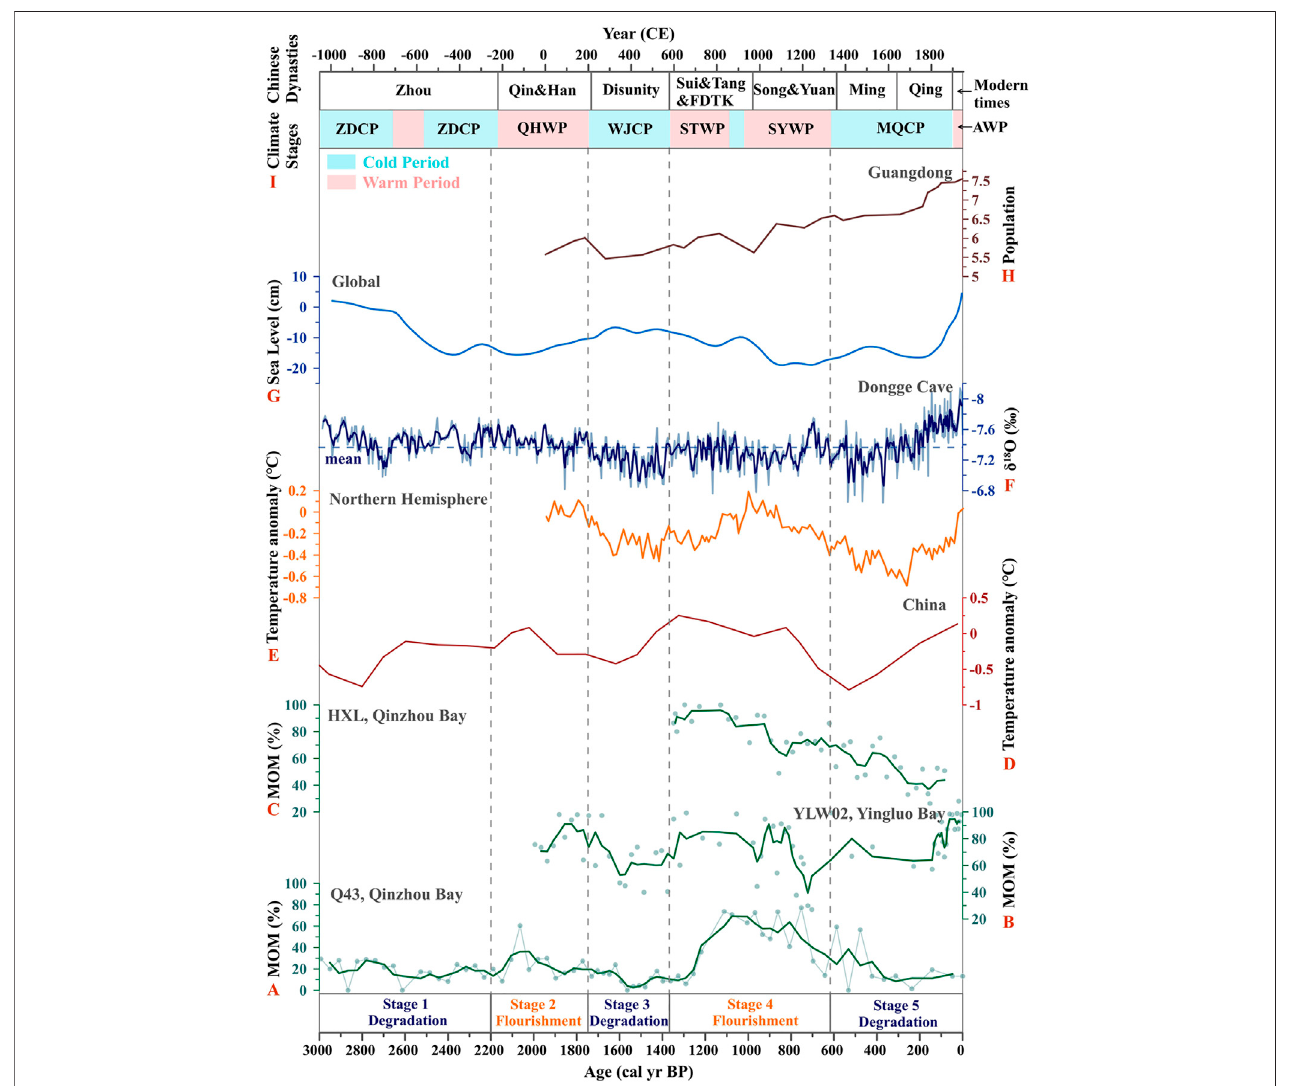
FIGURE5| Comparisonsbetweenchangesinmangrove-derivedorganicmatter(MOM)andnaturalandanthropogenicrecords: (A – C) variationsinMOMfromthe Q43(thisstudy),YLW02(Mengetal.,2017),andHXL(Xiaetal.,2019)cores,respectively,inGuangxicoasts; (D – E) temperatureanomalyinChina(HouandFang,2011) and theNorthern Hemispheric (Ljungqvist, 2010); (F) stalagmite δ 18 O records from Dongge Cave, SW China(Wang et al., 2005); (G) variation in theglobal sea level over the past 3,000 cal yr BP (Kemp et al., 2018; Miller et al., 2020) (H) population changes in Guangdong Province (logarithmic (base 10) scale (Zhao and Xie, 1988; Huang et al., 2018)); (I) Chinese dynasties and climatic stages (Zhu, 1973; Ge et al., 2014). The latter includes the Zhou Dynasty cold period (ZDCP), Qin-Han warm period(QHWP),Wei-Jincoldperiod(WJCP),Sui-Tangwarmperiod(STWP),Song-Yuanwarmperiod(SYWP),Ming-Qingcoldperiod(MQCP),andAnthropocenewarm period (AWP). The stages (Stage 1 – Stage 5) of mangrove development in Qinzhou Bay are divided by vertical broken lines.